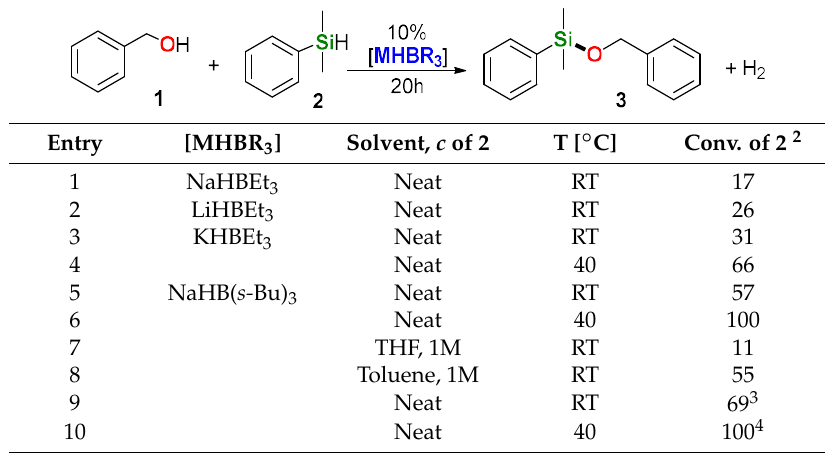
Table 1. Results of optimization of dehydrogenative coupling of 1 with 2 using various trialkylborohydride salts as promoters 1 .